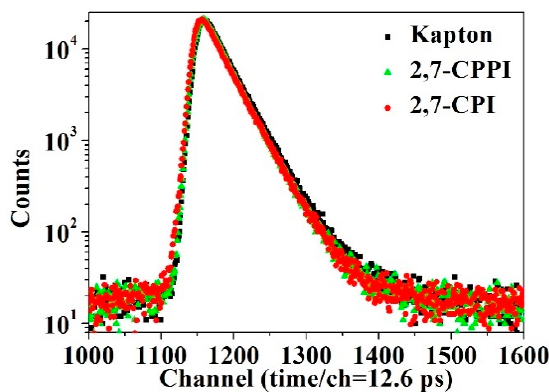
Figure 7. Positron lifetime curve measured for Kapton, 2,7-CPPI and 2,7-CPI films.